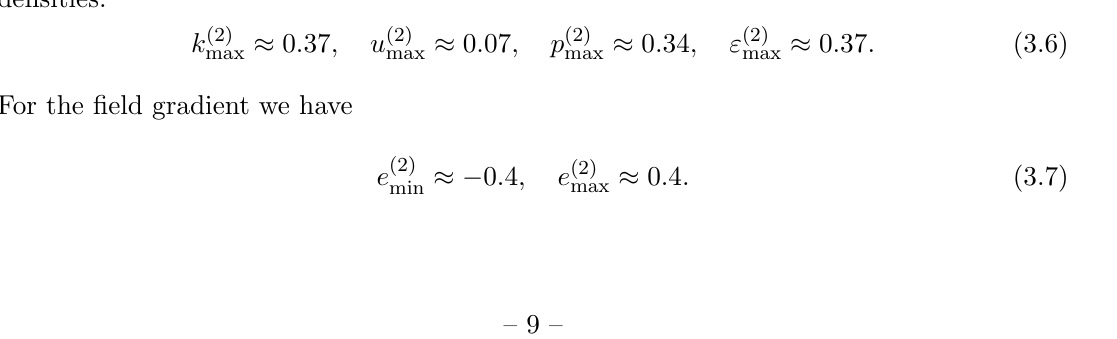
during the collision, and escape. Moreover, (cid:12)gure 4b shows that the kink and the antikink attract each other at small